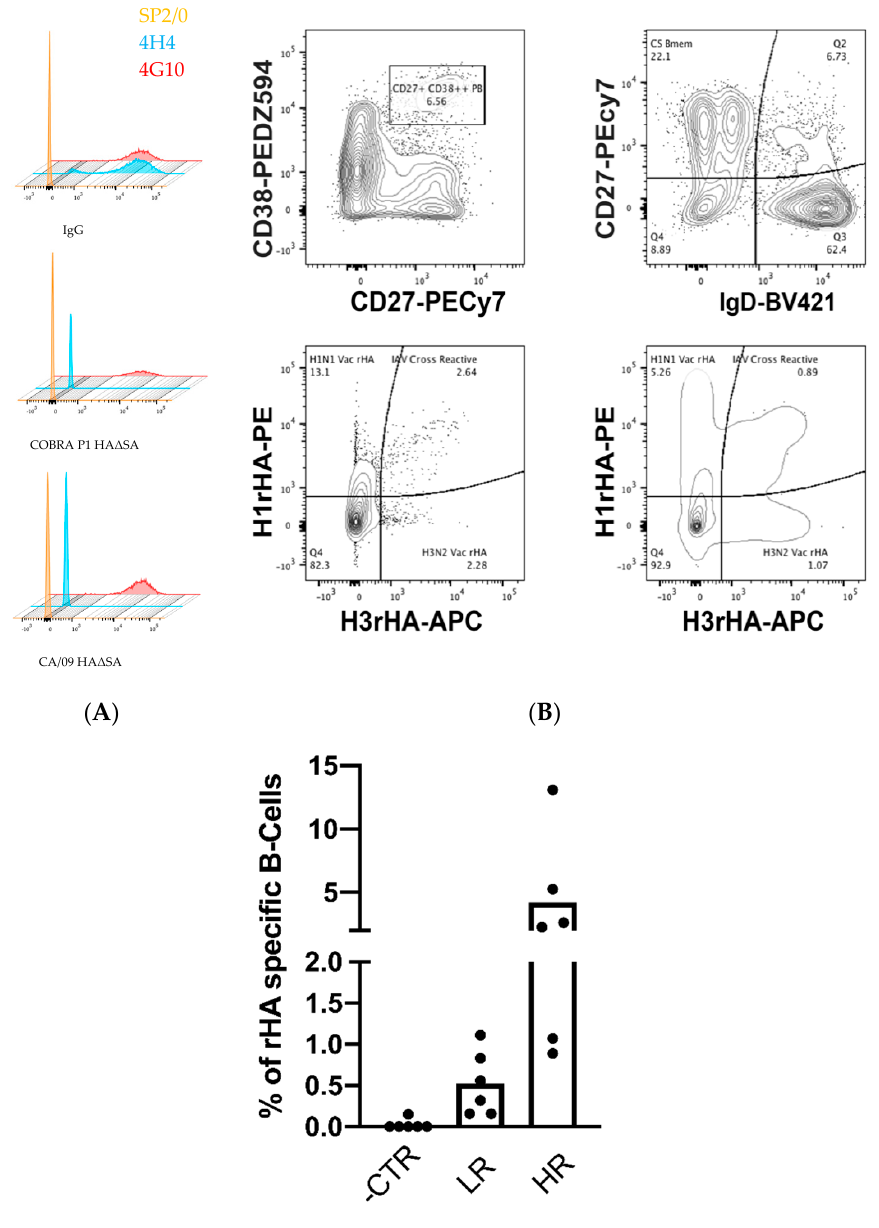
Figure 10. Fluorescent-conjugated rHA ∆ SA expressed by stably-transfected cell lines e ffi ciently identify HA-specific B-cells. ( A ) Representative flow panels of HA-directed (4G10) H1N1 specific hybridoma stained with CA / 09 and COBRA P1 rHA ∆ SA APC-conjugated probe. The SP2 / 0 cell line was used as negative control for IgG and rHA ∆ SA staining while the IgG + 4H4 hybridoma cell line was used as negative control for rHA ∆ SA staining. ( B ) Representative flow panel of rHA-specific plasmablasts (top left) and class-switched memory B-cells (top right) in a highly reactive influenza vaccinated subjects following rHA ∆ SA H1 ( y axis) and H3 ( x axis) probe staining (bottom left and right) as described in the Materials and Methods Section. ( C ) Frequency of rHA ∆ SA-specific cells in di ff erent B-cell compartments, measured as in B, from low- (LR) and high- (HR) reactive subjects. Fluorescent minus one (FMO) controls were used to set positive staining